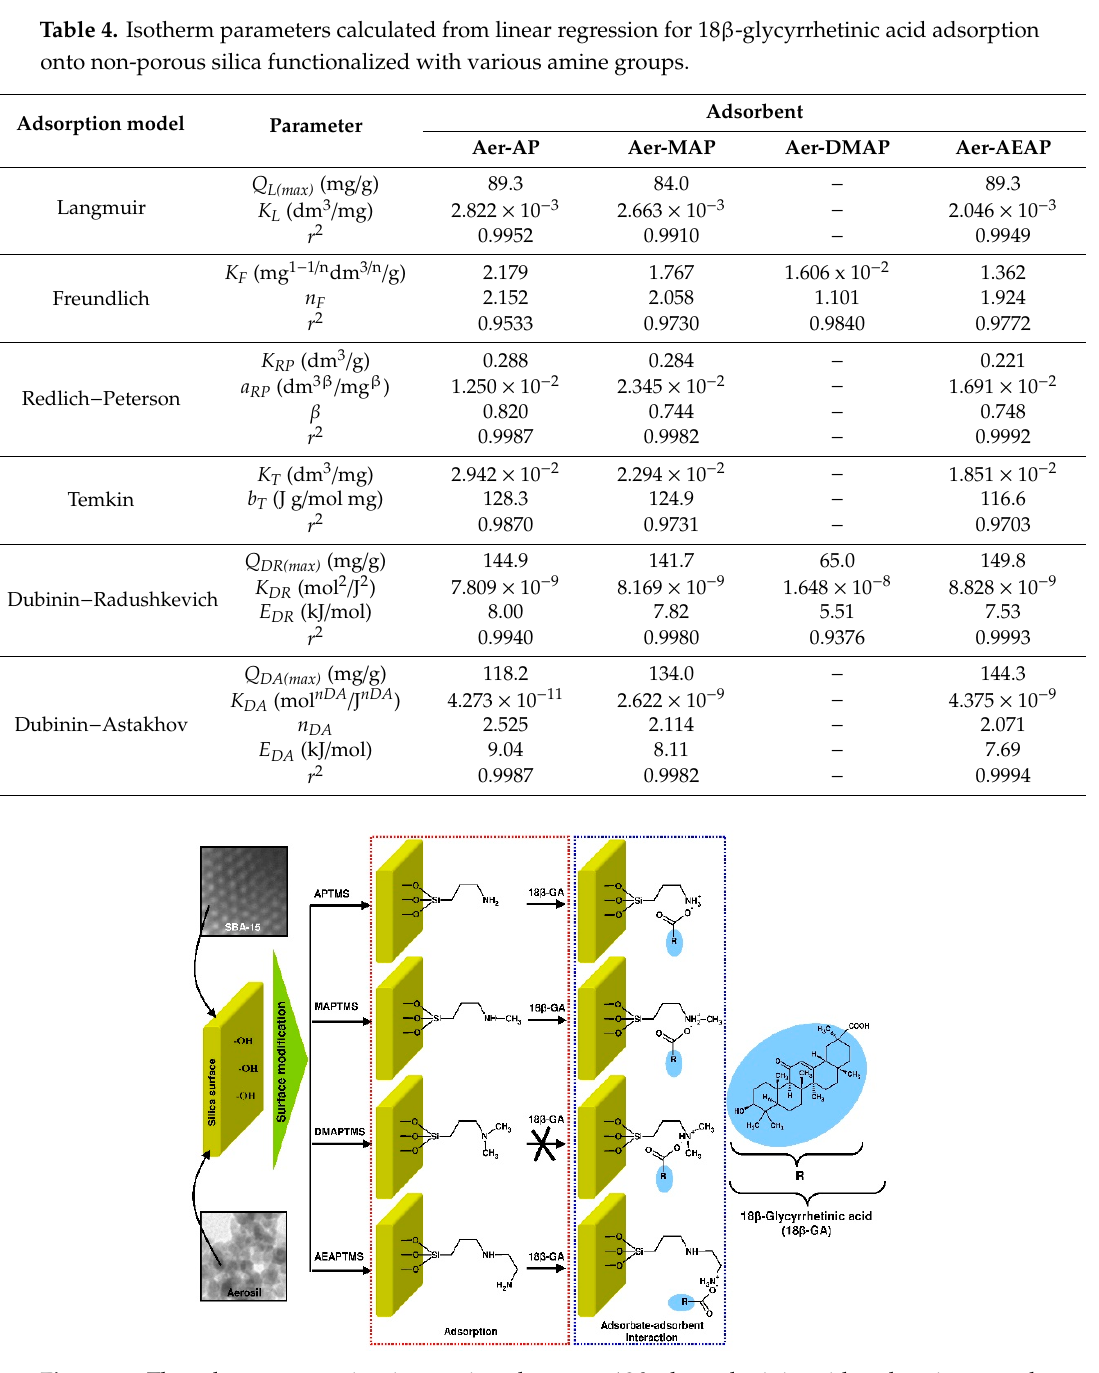
Figure 10. Comparison of experimental and predicted isotherms of 18 β -glycyrrhetinic acid adsorption onto ( A ) SBA-15-AP, ( B ) SBA-15-MAP, ( C ) SBA-15-DMAP, and ( D ) SBA-15-AEAP mesoporous adsorbents. The best fitted isotherm models derived from linear analysis are presented. Isotherm models: F, Freundlich; D-A, Dubinin-Astakhov; D-R, Dubinin-Radushkevich; L, Langmuir; R-P, Redlich-Peterson.